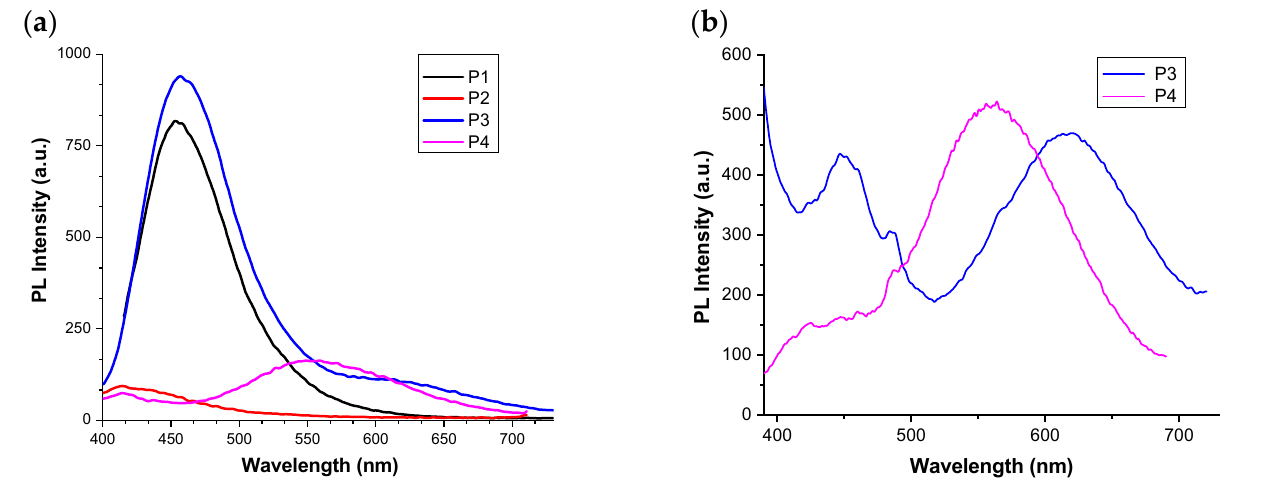
Figure 5. Fluorescence spectra of P1 – P4 in ( a ) CHCl 3 solution and ( b ) thin films cast from CHCl 3 solution.